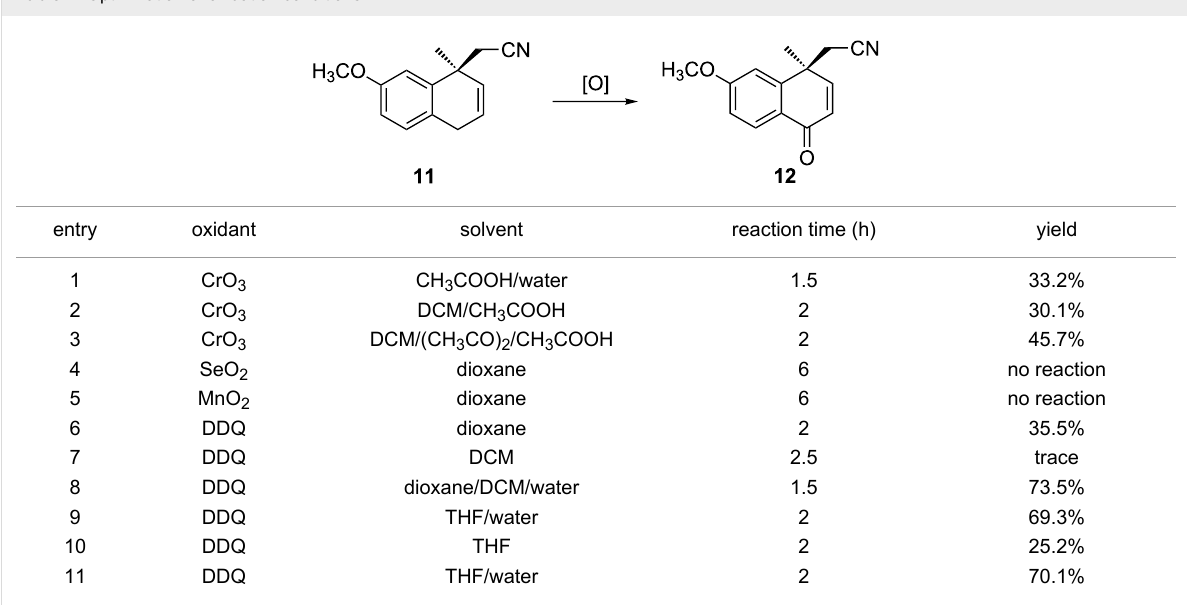
Table 2: Optimization of oxidation